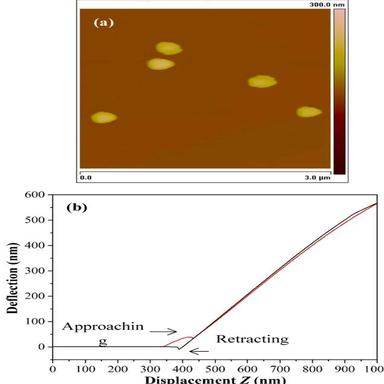
(a) AFM image of D-mSiO2-75 nanospheres deposited on the rigid substrate and (b) typical cantilever deflection vs Z-position curve recorded on an individual D-mSiO2-75 nanosphere.